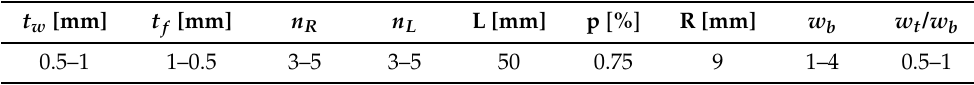
Table 1. Summary of the parameters and their corresponding values.